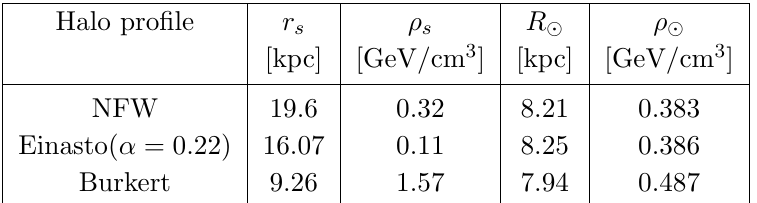
Table 1 . Dark matter mass model parameters for NFW [72], for Einasto [73] and for Burkert [74]